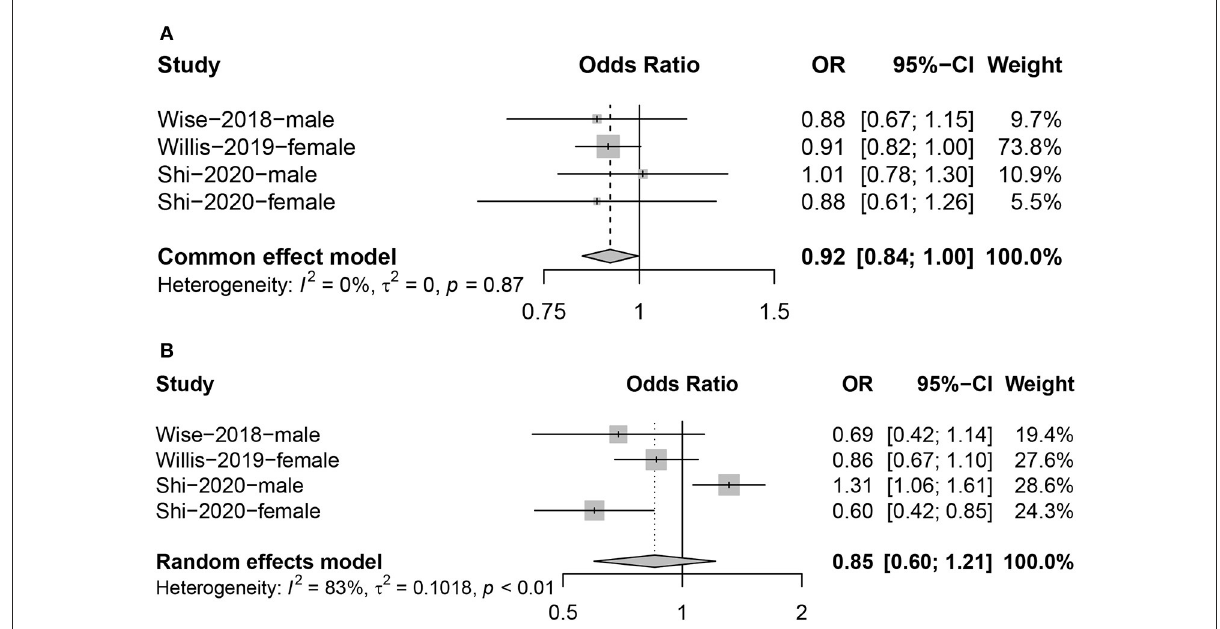
FIGURE4 Forest plot of the combined effect size of the effects of too short [ (A) : ≤ 7 hours] or too long [ (B) : ≥ 9 hours] sleep duration on fertility compared to 8